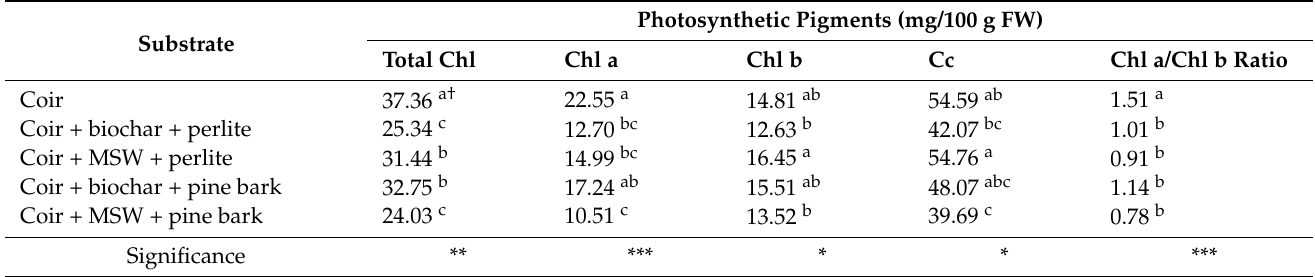
Table 4. Effect of substrates on leaf photosynthetic pigments’ content and Chl a/Chl b ratio. Photosynthetic Pigments (mg/100 g FW) Substrate Total Chl Chl a Chl b Cc Chl a/Chl b